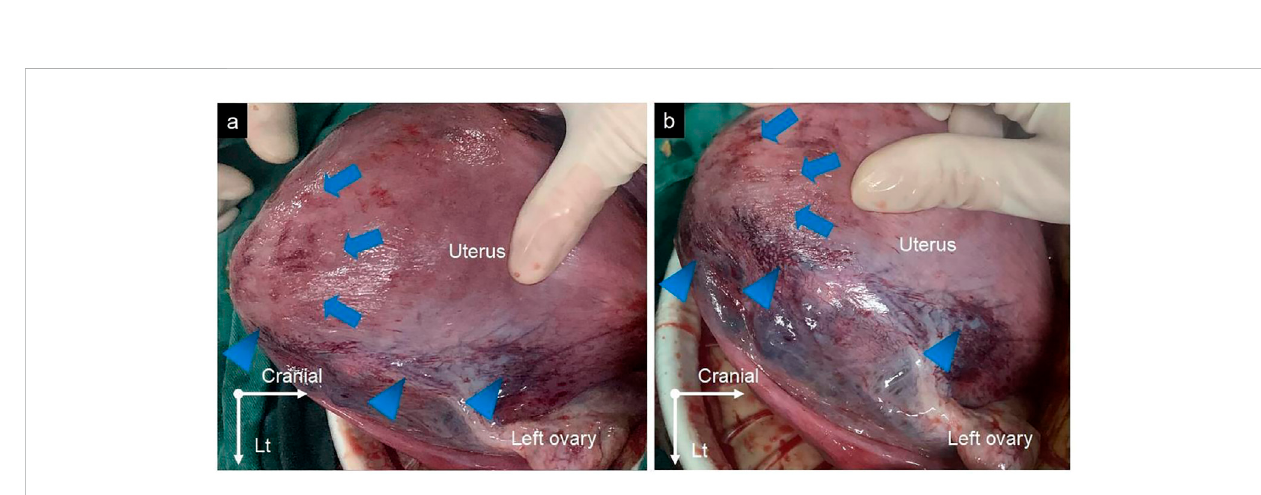
FIGURE 2 (A,B) The protuberance in the left fundus of the uterus disappeared (blue arrows), with a bruise on the left uterine horn (blue